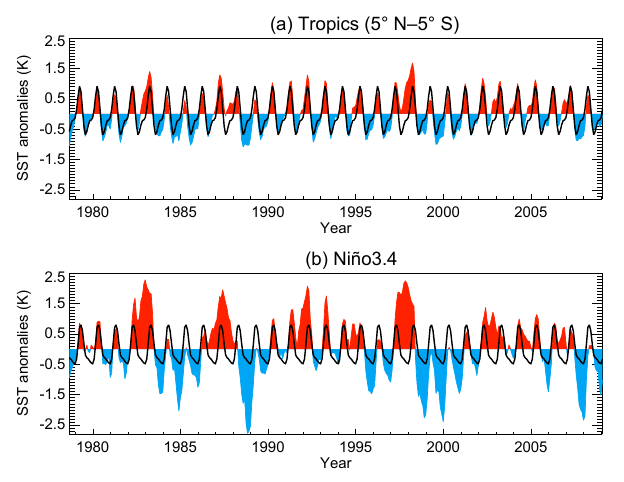
Figure 2. Comparison of monthly mean sea surface temperature (SST) anomalies (red and blue) from the 30-year mean (1979–2008) of the CMIP5 AMIP SSTs used in Experiment 1 with the mean annual cycle (black curve) for the same period. (a) Average for all longitudes between 5 ◦ N and 5 ◦ S. (b) Average for the Niño 3.4 region (120 ◦ –170 ◦ W, 5 ◦ N–5 ◦